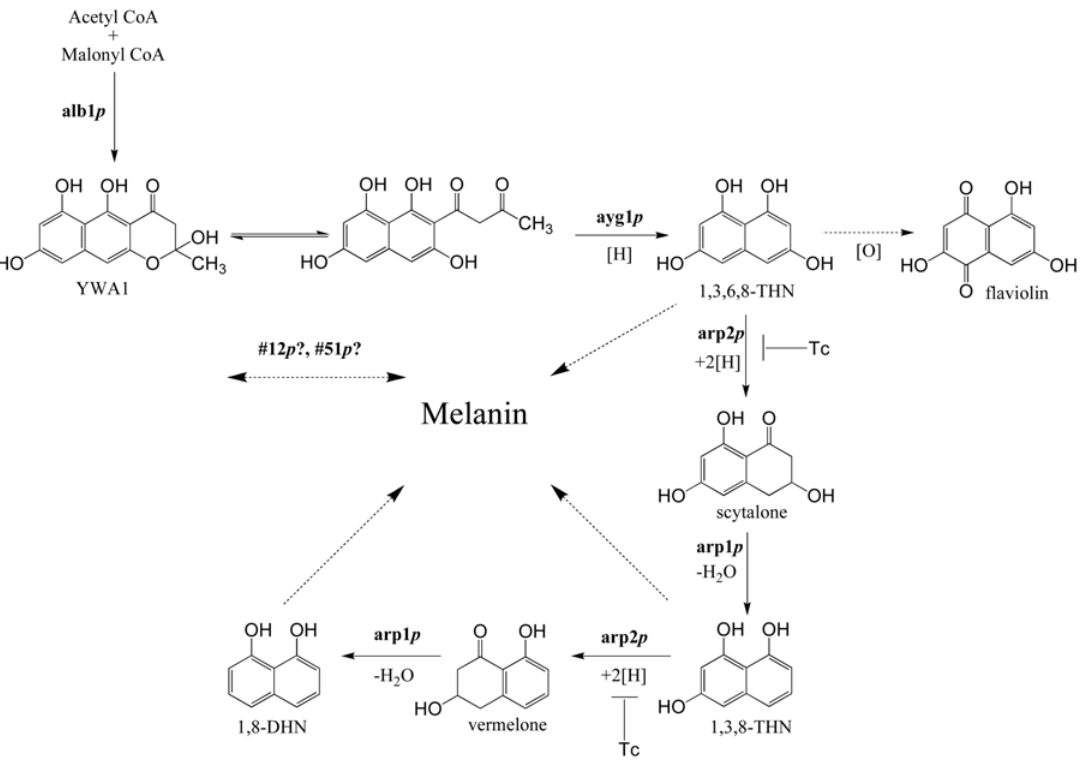
Figure 3. Schematic representation of the biosynthesis of DHN-melanin in A.fumigatus . Solid arrows indicate the previously defined melanin pathway. Dashed arrows indicate possible branching pathways from the main melanin pathway. Reduction [H], oxidation [O], and dehydration [ 2 H 2 O] steps are indicated accordingly. Tc indicates a reduction step that can be inhibited by the fungicide tricyclazole.